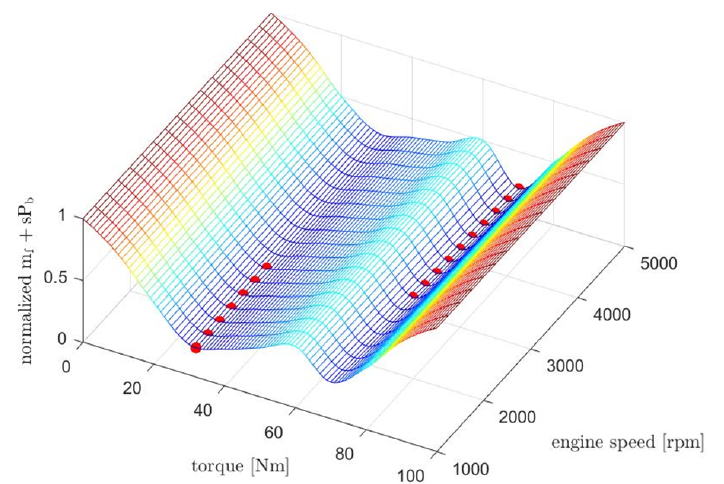
Figure 9. Example of non-convexity in Equation (26) leading to strongly different torques minimizing the cost functions at two similar engine